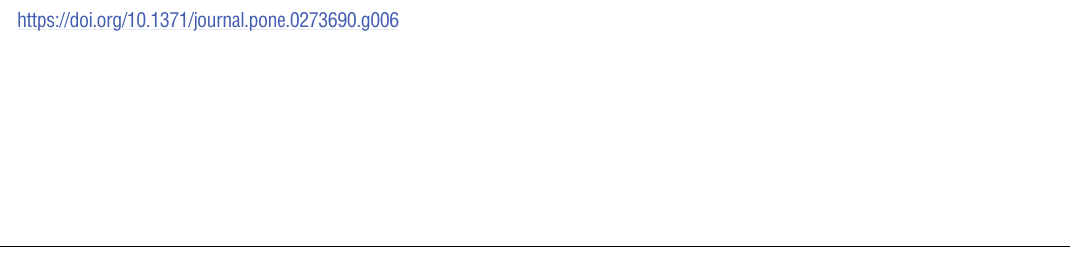
PLOS ONE | https://doi.org/10.1371/journal.pone.0273690 August 31,